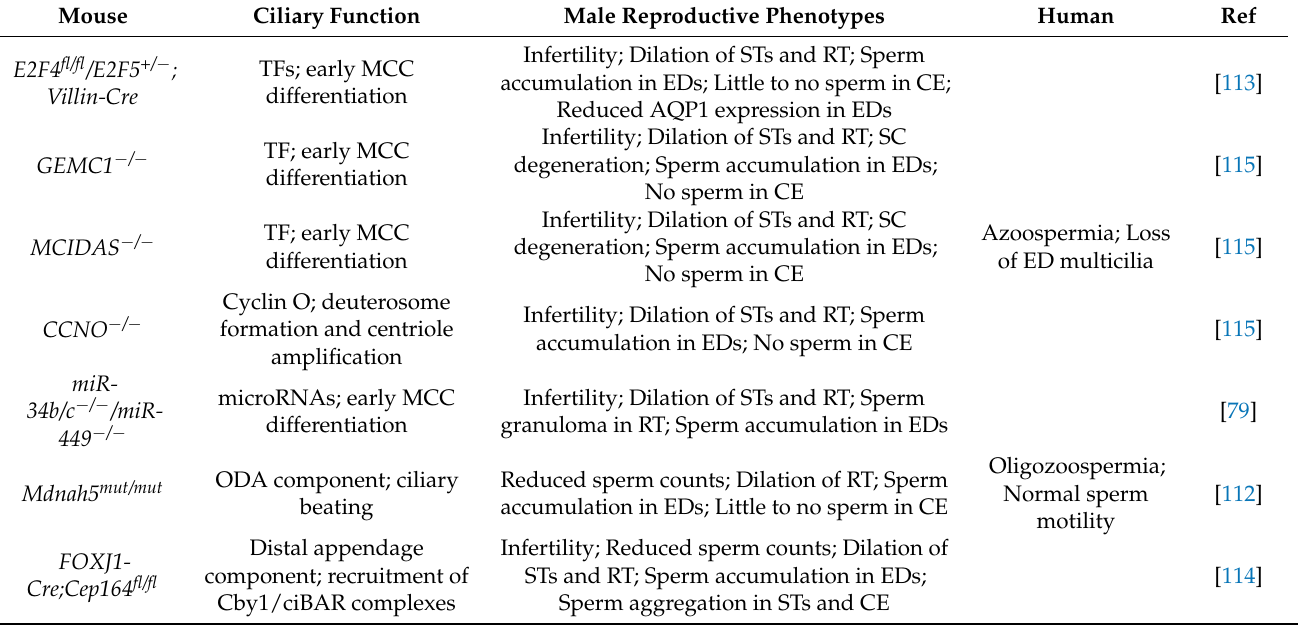
Table 1. Mouse models and human patients with defective ED